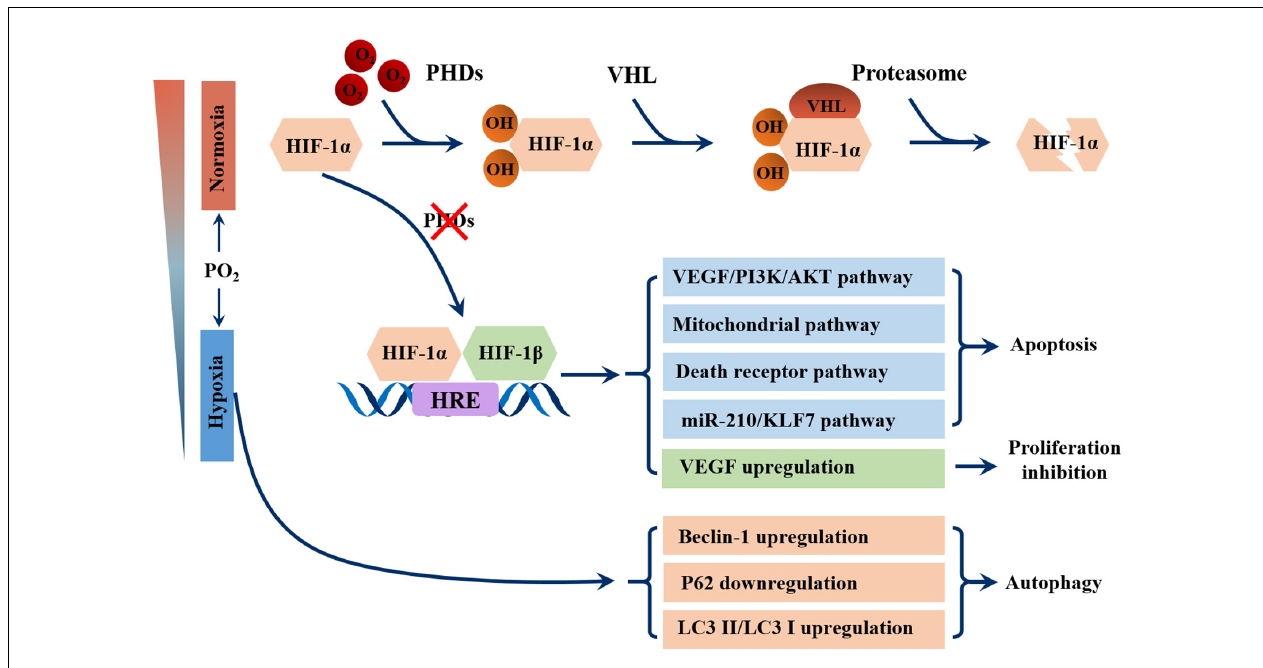
FIGURE 1 | Schematic overview of the pathways involved in germ cell damage caused by HIF-1 α . In the presence of oxygen, prolyl hydroxylases (PHDs) hydroxylate the HIF-1 α , which generates a binding site for the von Hippel Lindau (VHL) protein, a component of the ubiquitin ligase complex, leading to proteasomal degradation of HIF- α . During hypoxia, the enzymatic activity of PHDs is inhibited, leading to stabilization of HIF-1 α subunits. After translocation to the nucleus, they complex with their β subunit and bind to hypoxia responsive elements (HREs). The genes activated by HIF perform the following functions in germ cells: apoptosis, which is caused by VEGF/PI3K/AKT signaling pathway, mitochondrial pathway, death receptor pathway and miR210/KLF7 pathway; Proliferation inhibition, which is caused by activating VEGF transcription. Hypoxia can also upregulate the expression of Beclin-1 and LC3II/LC3I, and downregulate the expression of P62 to promote germ cell